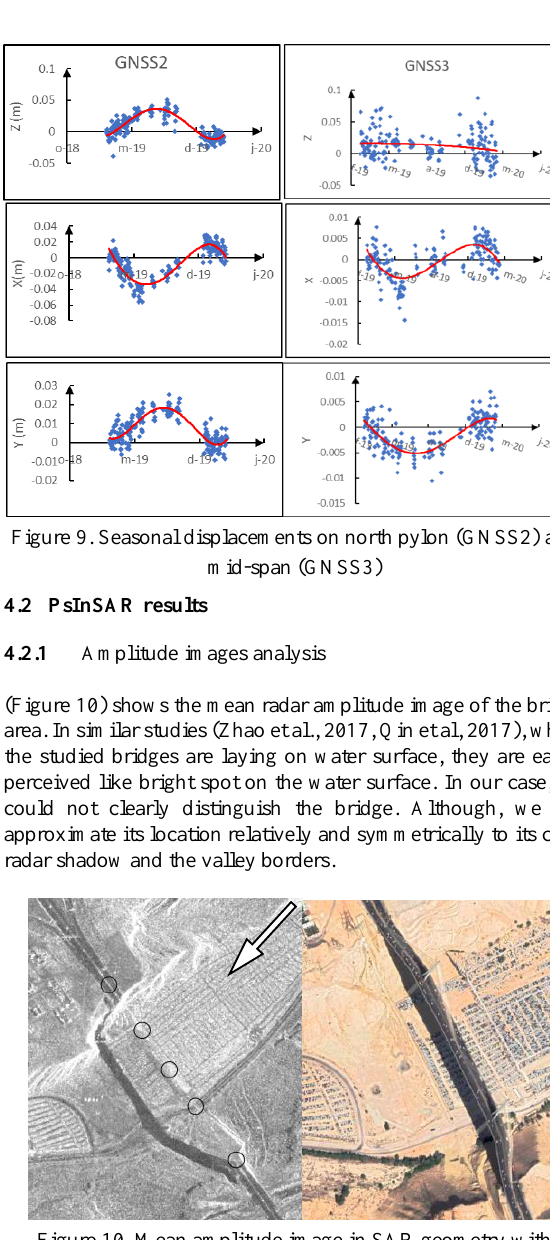
Figure 12. Corrected 3D position of the selected